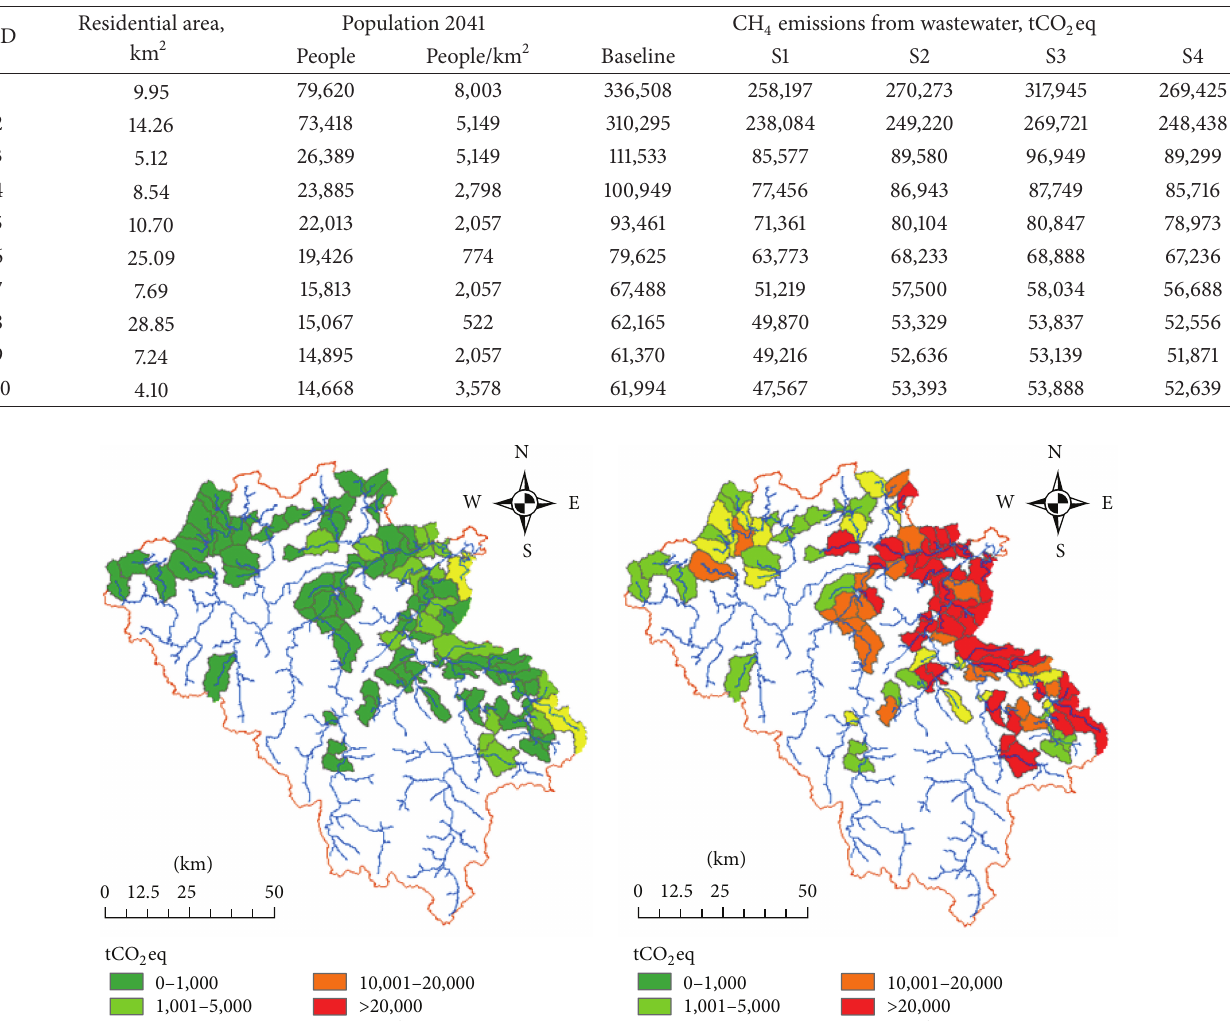
Table 4: GHG emissions projection from 10 most populated watersheds.